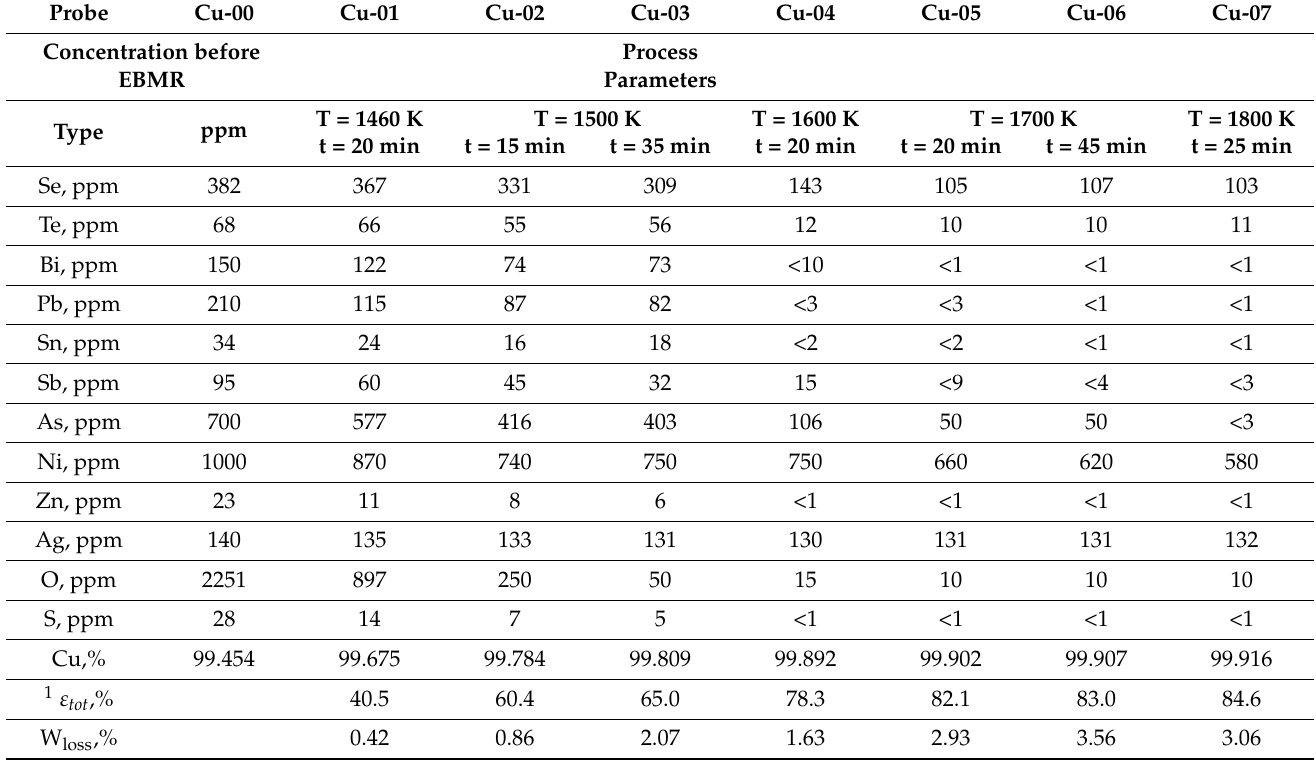
Table 1. Concentration of impurities at electron beam processing of copper technogenic material.